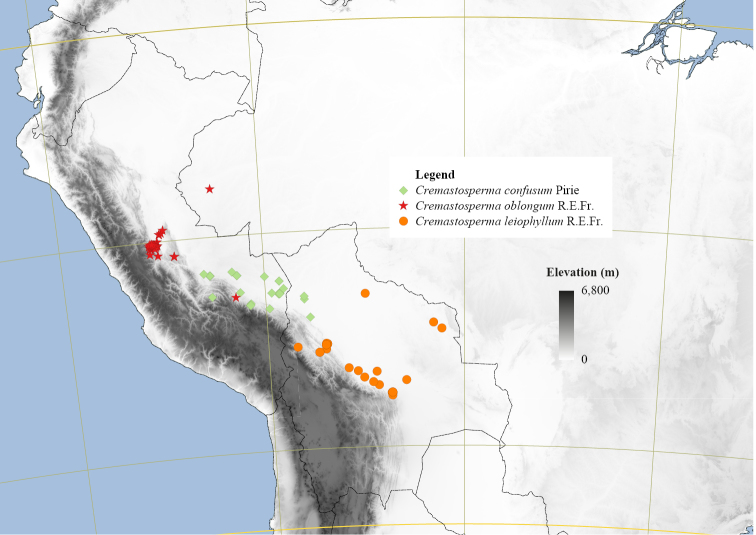
Distribution of Cremastospermaconfusum Pirie, C.leiophyllum R.E.Fr.; and C.oblongum R.E.Fr.